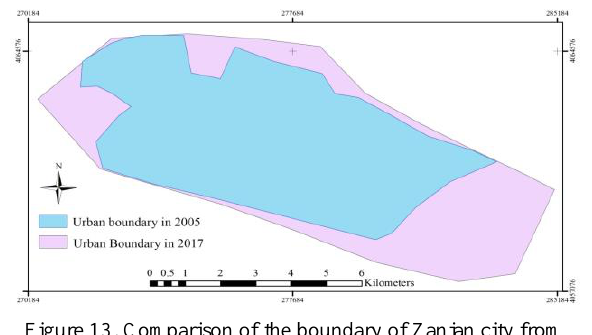
Figure 13. Comparison of the boundary of Zanjan city from 2005 through 2017